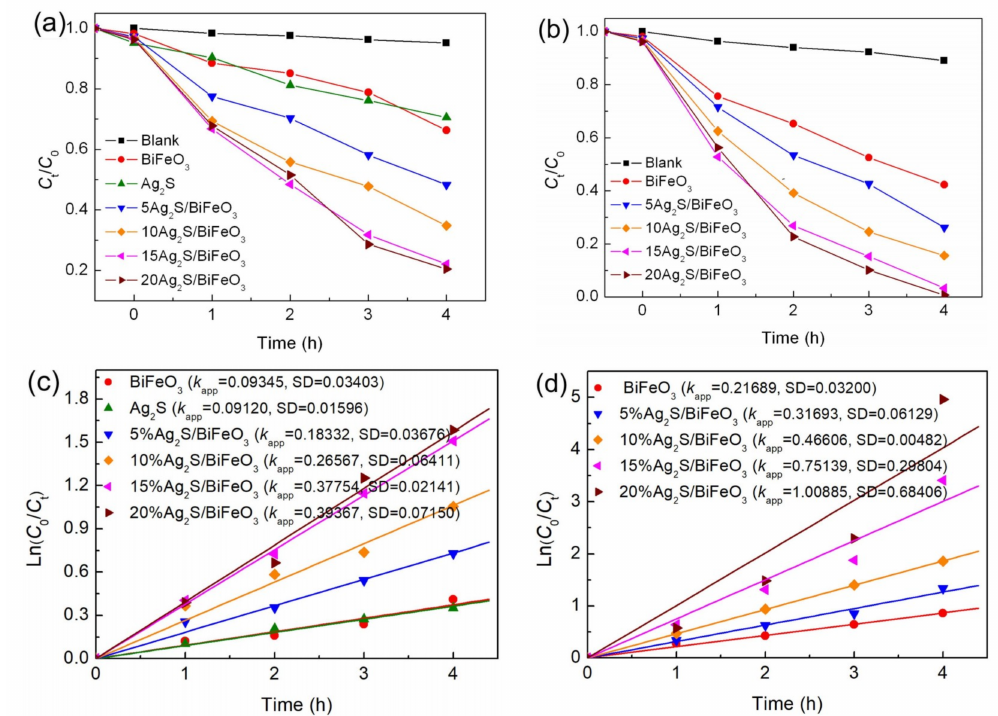
Figure 6. ( a ) Photocatalytic activities of Ag 2 S, BiFeO 3 , and Ag 2 S/BiFeO 3 composites toward the degradation of MO under visible-light irradiation, along with the blank and adsorption experiment results. ( b ) Photo-Fenton catalytic activities of BiFeO 3 and Ag 2 S/BiFeO 3 composites toward the degradation of MO under visible-light irradiation, and in the presence of H 2 O 2 , along with blank and adsorption experimental results. ( c ) Plots of Ln( C t / C 0 ) vs reaction time t for the photocatalytic degradation of MO over the samples. ( d ) Plots of Ln( C t / C 0 ) vs reaction time t for the photo-Fenton catalytic degradation of MO over the